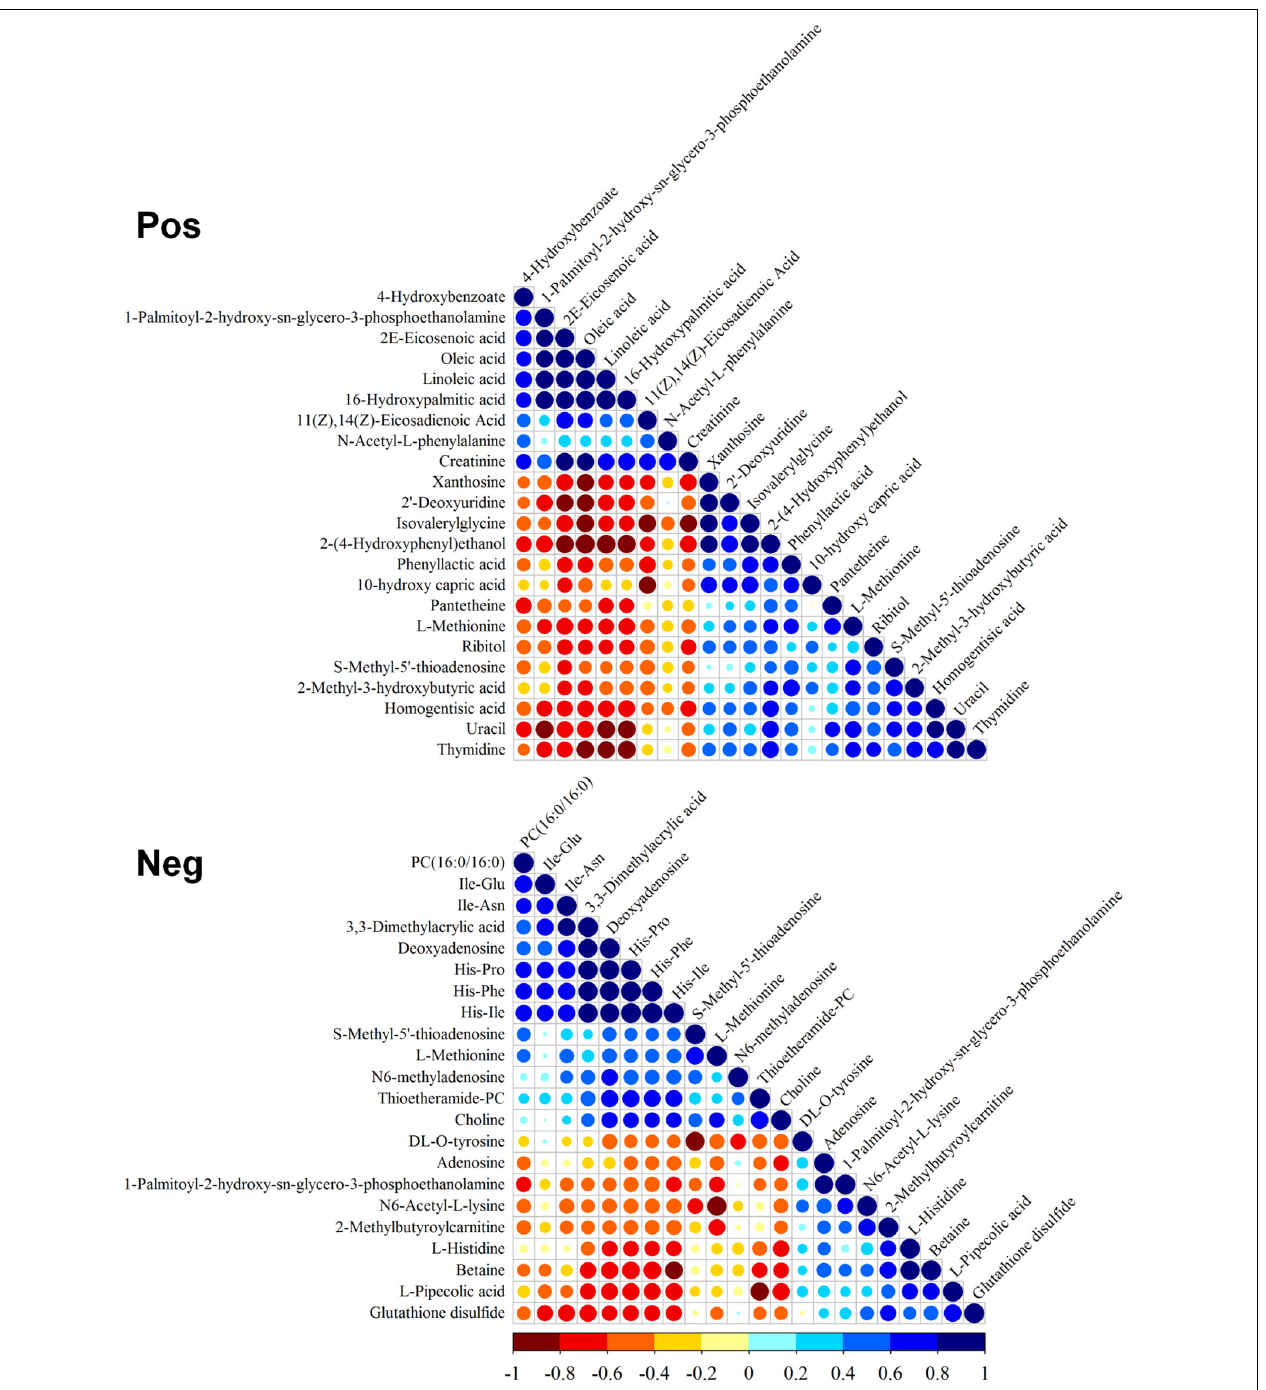
FIGURE 2 | Correlation of differential metabolites. Pos, positive mode; Neg, negative mode. Blue and red indicate positive and negative correlation, respectively.